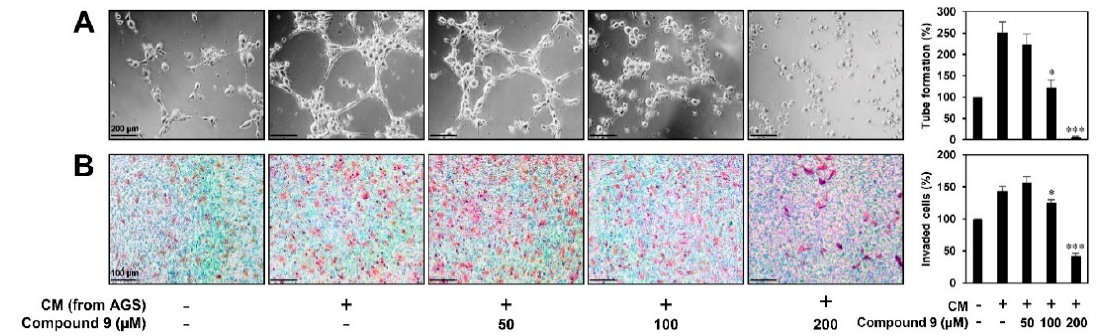
Figure 5. The inhibitory activity of compound 9 on tumor cell-induced angiogenesis. AGS gastric cancer cell-induced angiogenesis was assessed using ( A ) a conditioned medium from tumor cells for in vitro tube formation assay and ( B ) an in vitro co-culture system based on the chemoinvasion assay. ( A ) The basal level of the tube formation of HUVECs treated with non-conditioned medium without AGS cells was normalized to 100%. * p < 0.05, *** p < 0.001 vs. the conditioned medium from untreated AGS cells. ( B ) The basal level of the invasiveness of HUVECs that were incubated in serum-free medium without AGS cells was normalized to 100%. * p < 0.05, *** p < 0.001 vs. the control with untreated AGS cells. Each value represents the mean ± SD from three independent experiments.